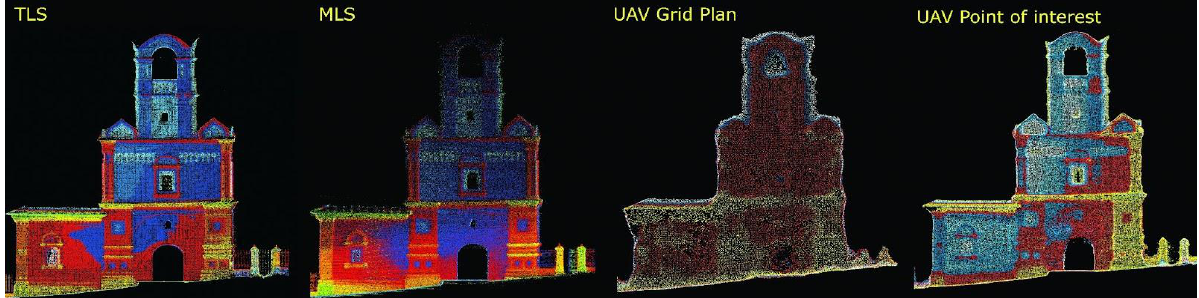
Figure 6 . Visualization of morphological quality of spatial data through the “elevation map” view applied to the vertical front of the Church of the Epiphany, one of the Heritage built objects present in Solikamsk historical center.